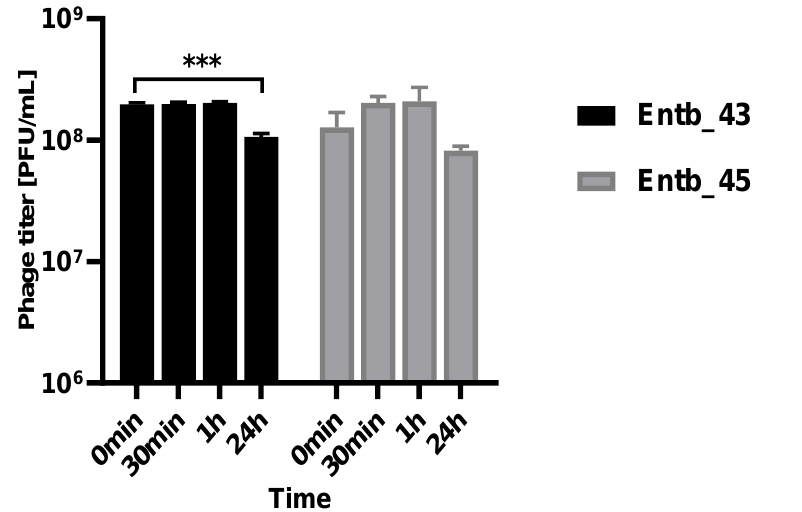
Figure 12. Phage titers after incubation in a urine sample (after 30 min, 1 h, and 24 h of incubation at 37 ◦ C). Samples at the start of the experiments (0 min) were treated as controls. Error bars represent the standard deviation ( ± SD) of the mean phage titers. *** p < 0.001.